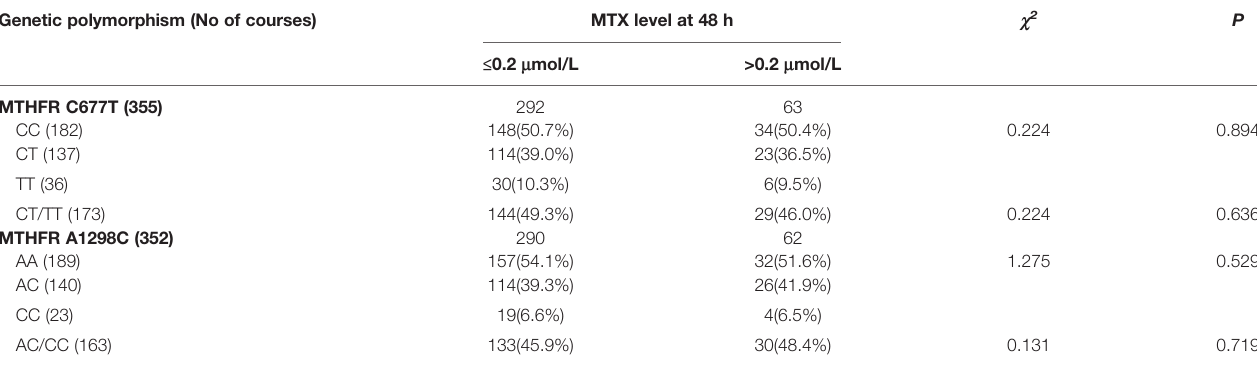
TABLE 4 | Associations between genetic polymorphisms and plasma MTX level at 48 h. Genetic polymorphism (No of